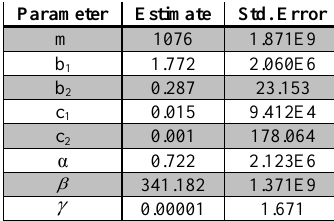
Table 1. Model parameter